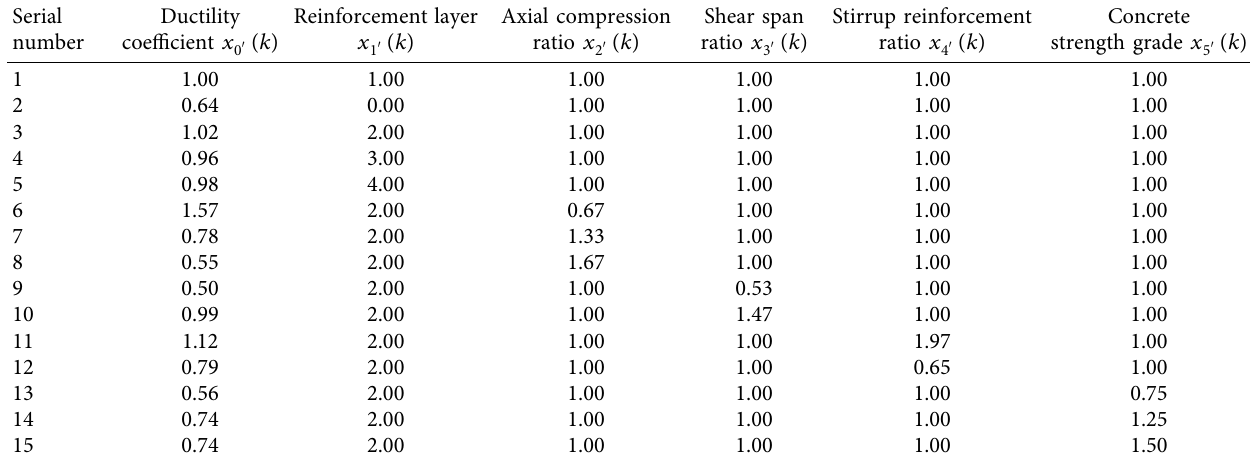
Table 2: Initialized data of the specimens.